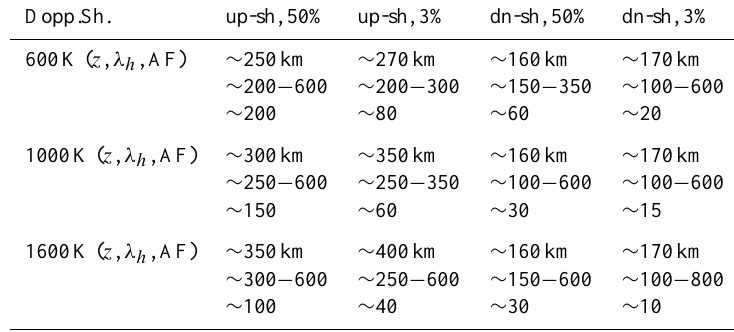
Table 3. As in Table 2, but only for up-shifted and down-shifted GWs for a zonal wind in the thermosphere of 200ms − 1 . Dopp.Sh. up-sh, 50%